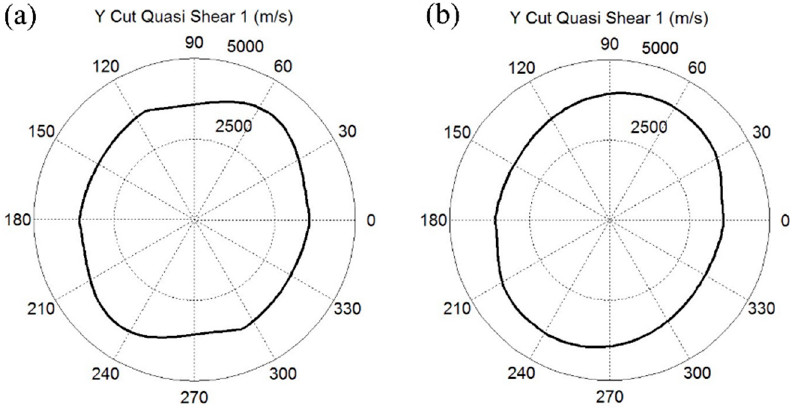
Figure 8. Directional group wave velocity in LiNbO 3 for slow transverse wave velocity ( a ) without piezo stiffening ( b ) with piezo stiffening mode.